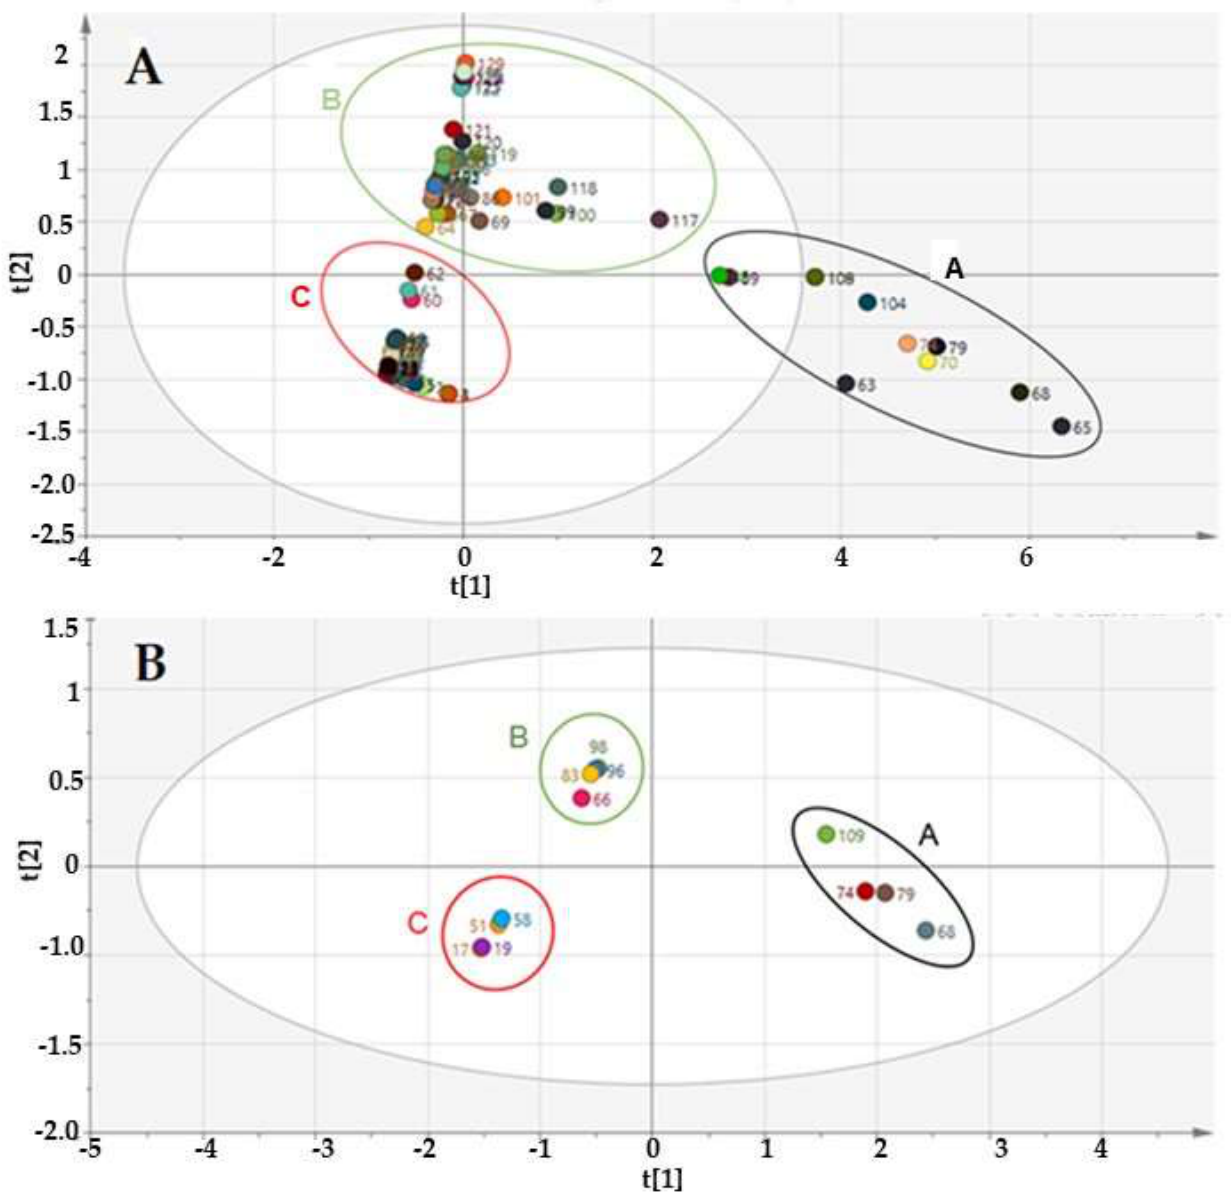
Figure 2. PCA score plot of ( A ) volatiles and non-volatile compounds and their clusters and ( B ) volatile compounds indicating three well-defined clusters of compounds in the hexane and dichloromethane extract of MOS oils.